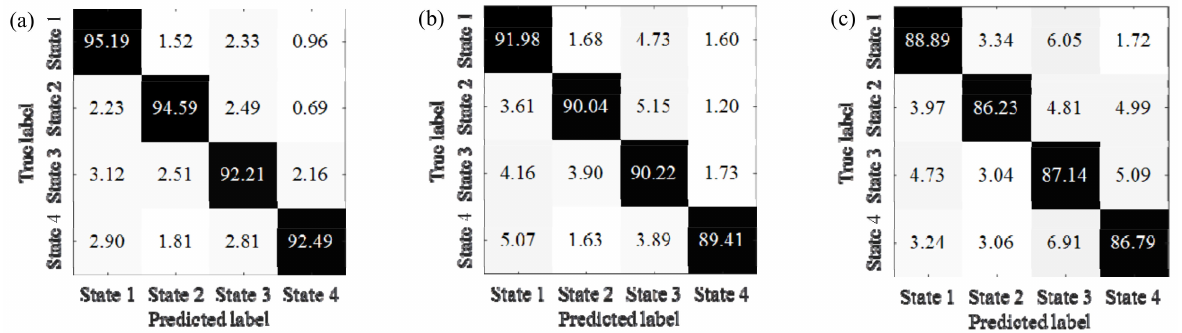
Figure 8. The confusion matrixes among IWM’s bearing states by different methods: ( a ) proposed method, ( b ) K-AHNs, ( c )